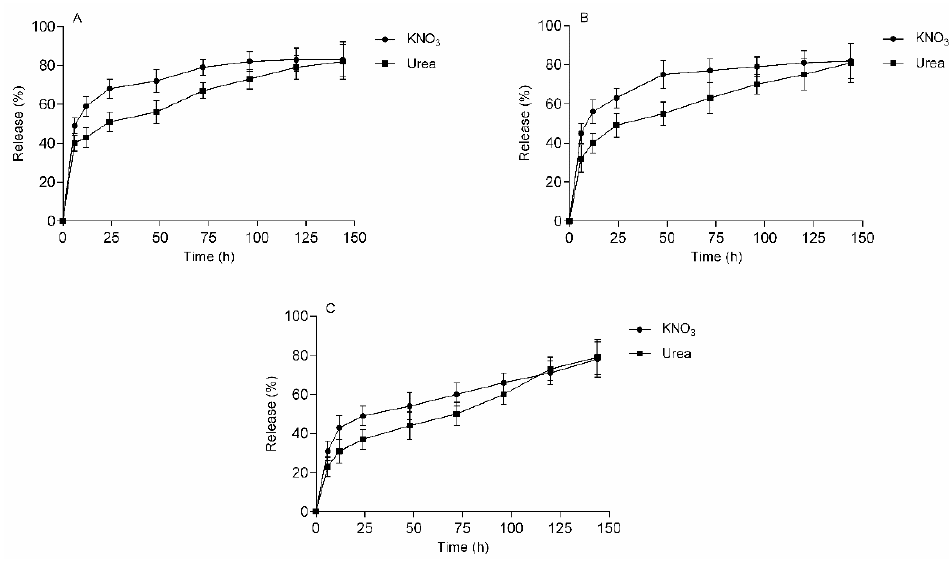
Figure 10. Simultaneous release of potassium nitrate and urea from ( A ) H5CA, ( B ) H10CA and ( C ) H15CA; as performed in distilled water at room temperature; data refer to mean values ± SD (n= 3).